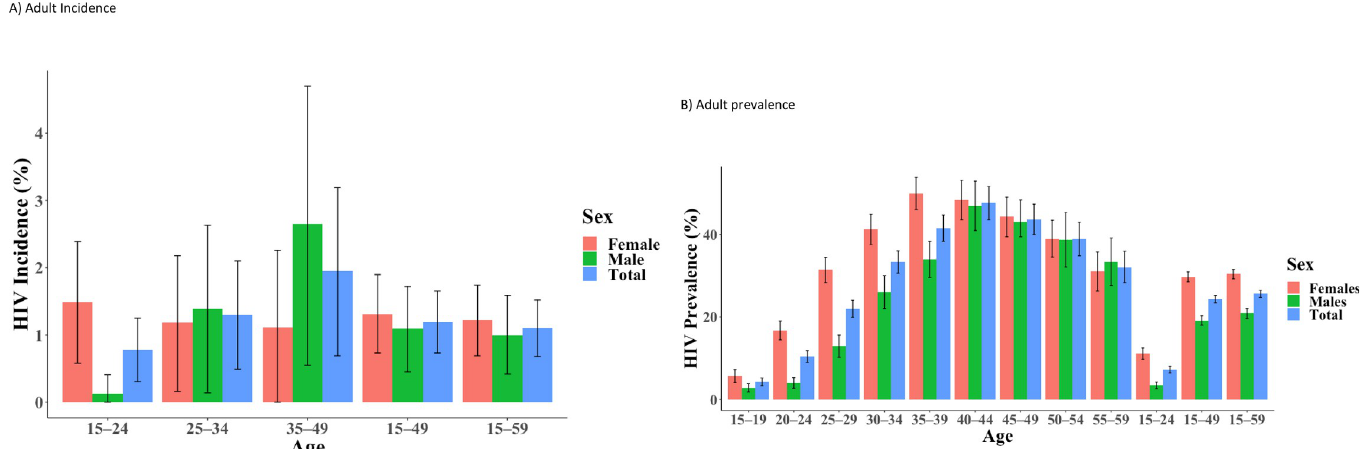
Fig 1. HIV incidence and prevalence in adults aged 15–59 years by age and sex in Lesotho, 2016–2017. A) Adult incidence B) Adult prevalence.